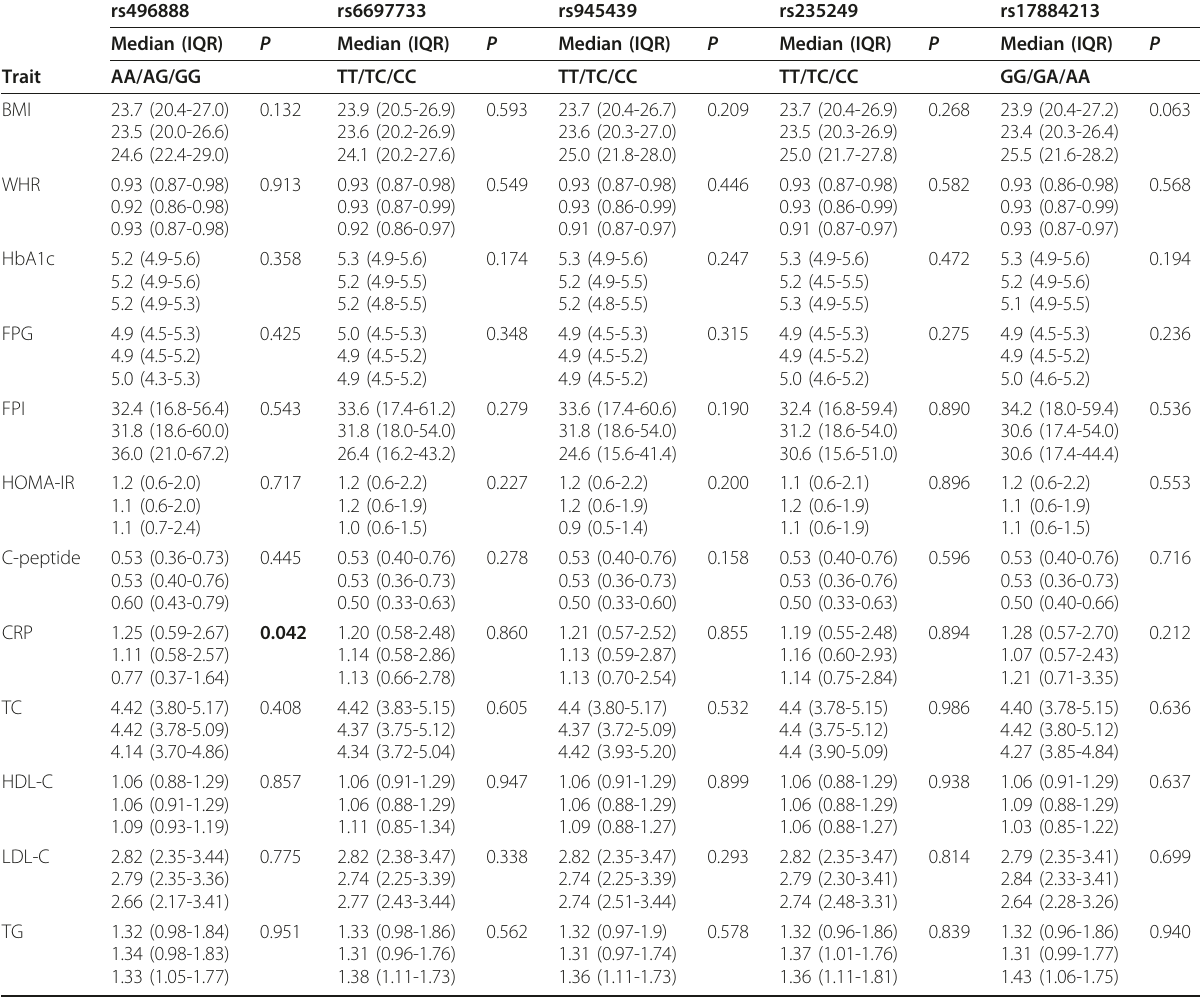
Table 4 Association analysis of SNPs with quantitative traits in control subjects in the initial